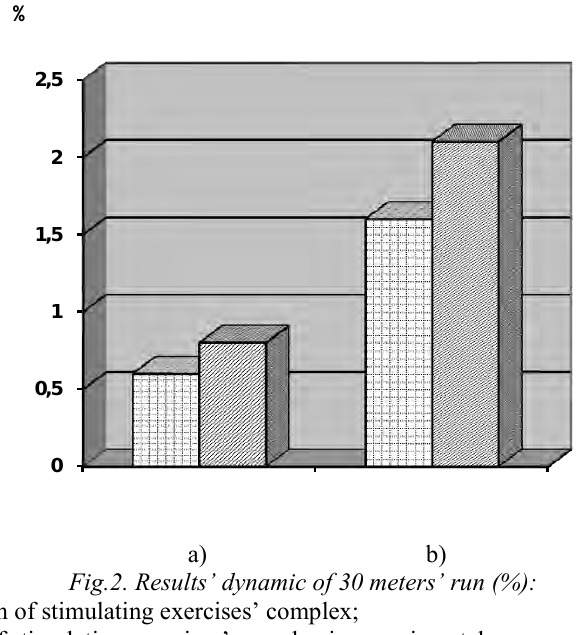
Fig.2. Results’ dynamic of 30 meters’ run